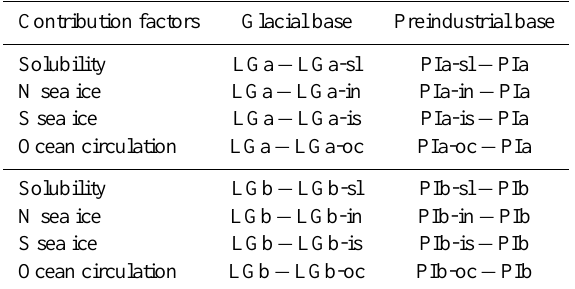
Table 2. How the climate factor contributions to the ocean carbon cycle are